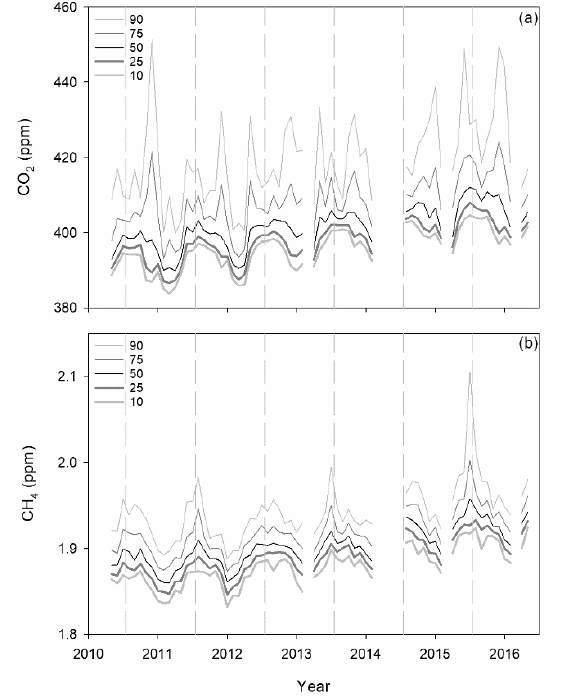
Figure 4. Selected percentiles calculated from monthly concentrations. ( a ) CO 2 , ( b ) CH 4 .